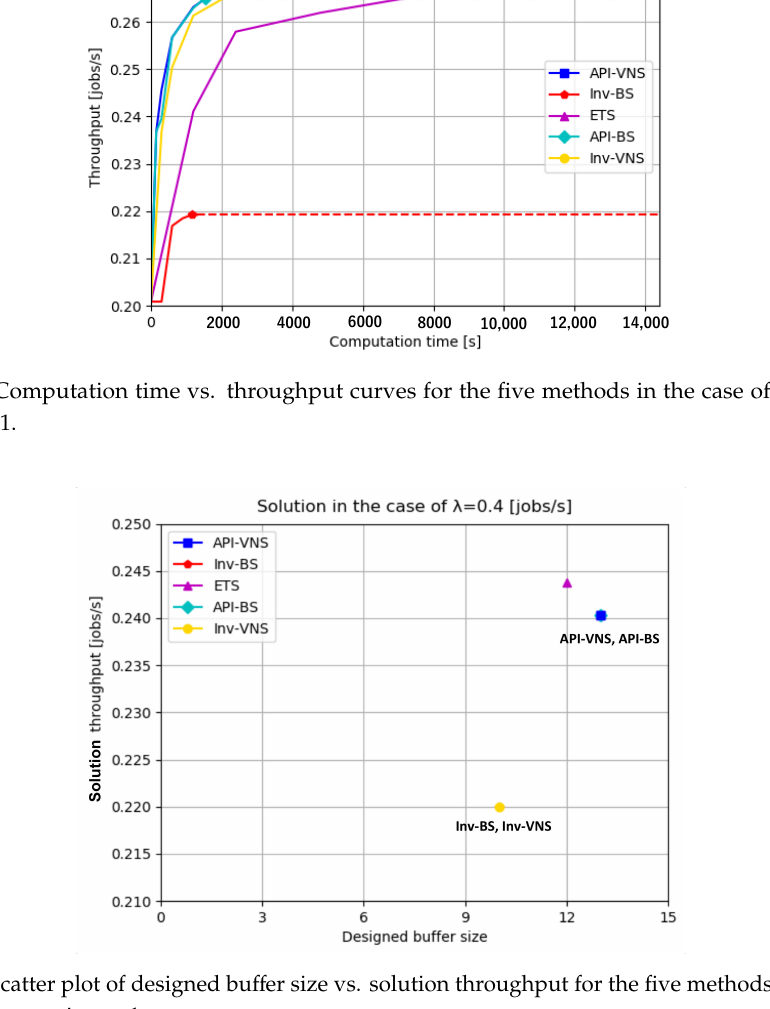
Figure 11. Scatter plot of designed bu ff er size vs. solution throughput for the five methods in the case of λ = 0.4 in experiment